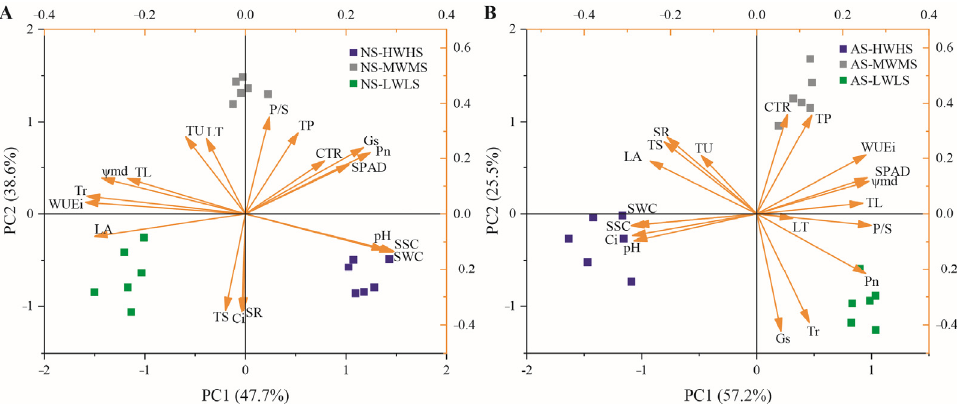
Figure 5. Biplot of principal components analysis (PCA) for the photosynthetic characteristics and soil and leaf physiological traits for two species of ( A ) N. sibirica and ( B ) A. sparsifolia . The positions of the squares and arrows indicate the composite principal component score of each treatment and trait,